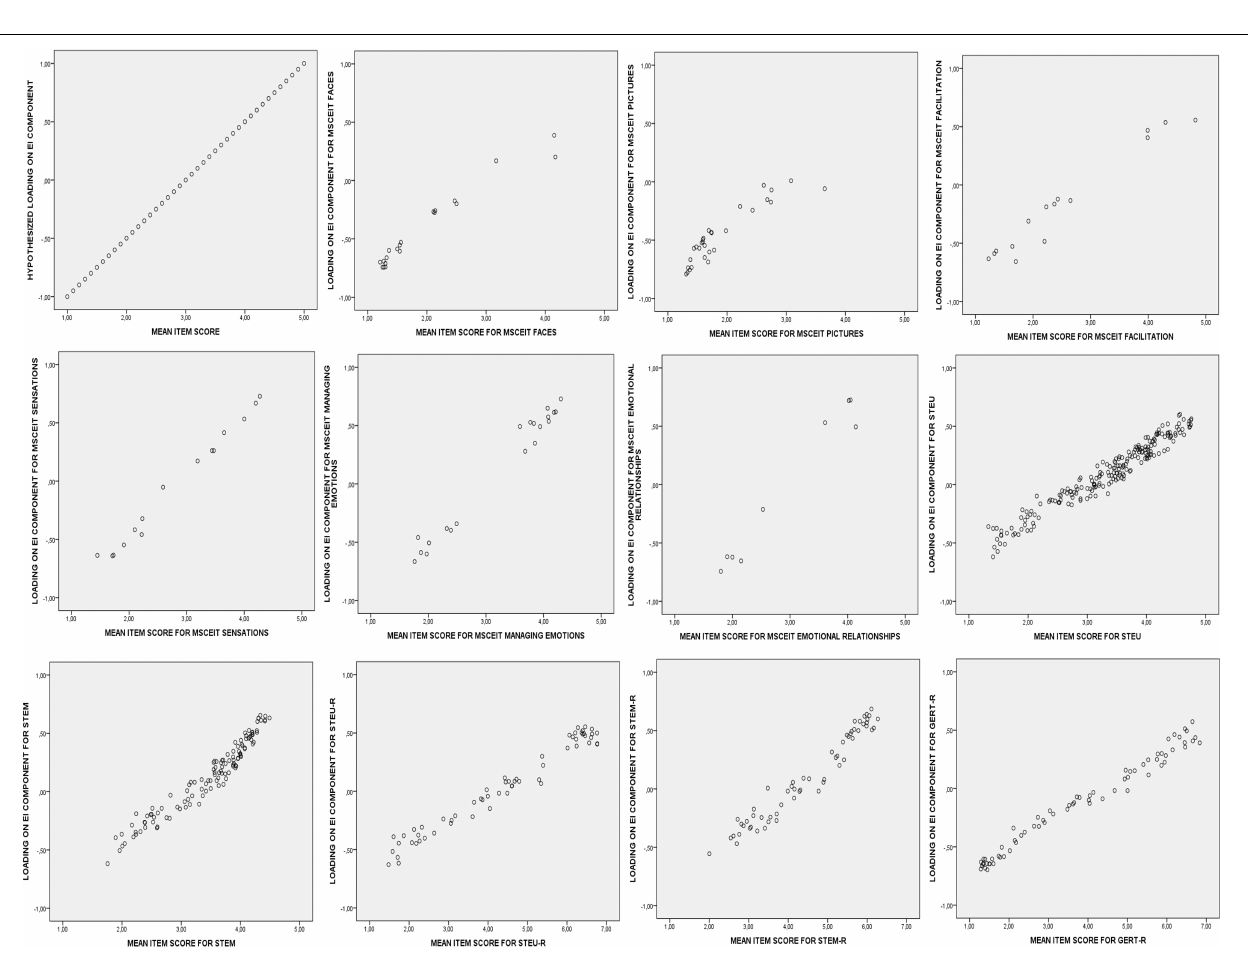
FIGURE 1 | Hypothetical and observed plots of the mean item scores and the item loadings on the bipolar EI component for the 11 EI